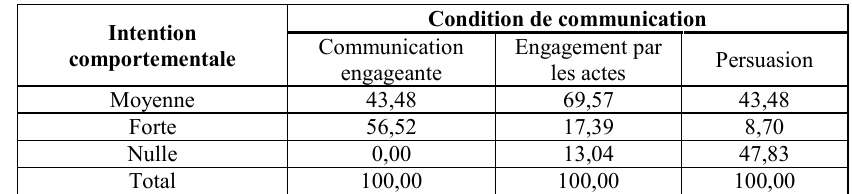
Table 1. Tableau de contingence en %.